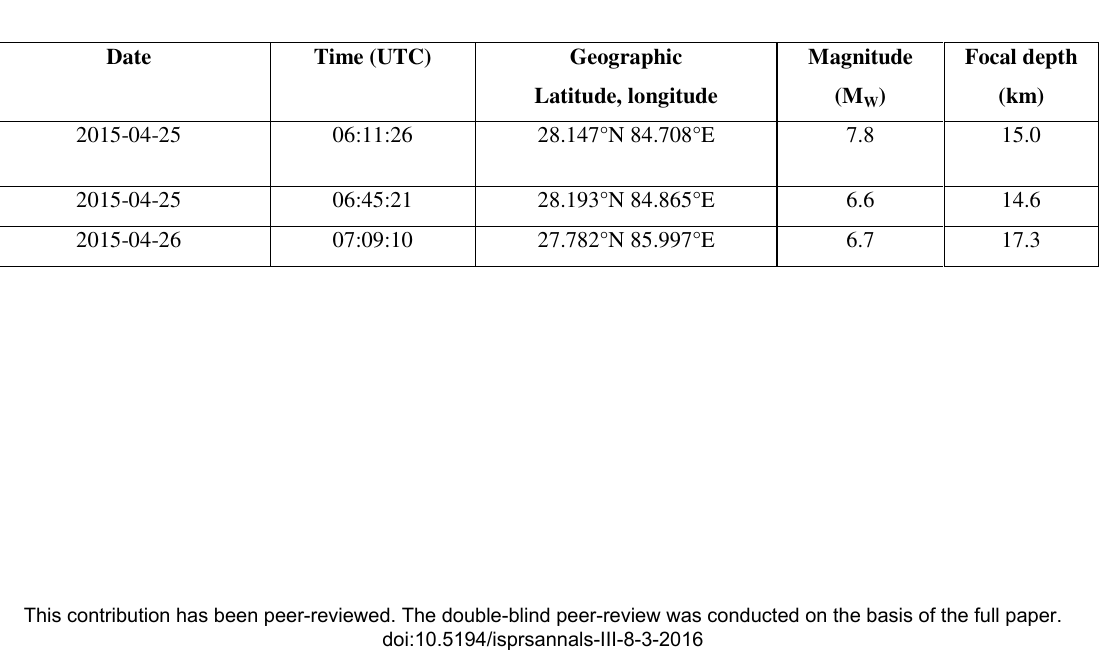
Table 1. Characteristics of the Nepal earthquake and its main after shocks (reported by